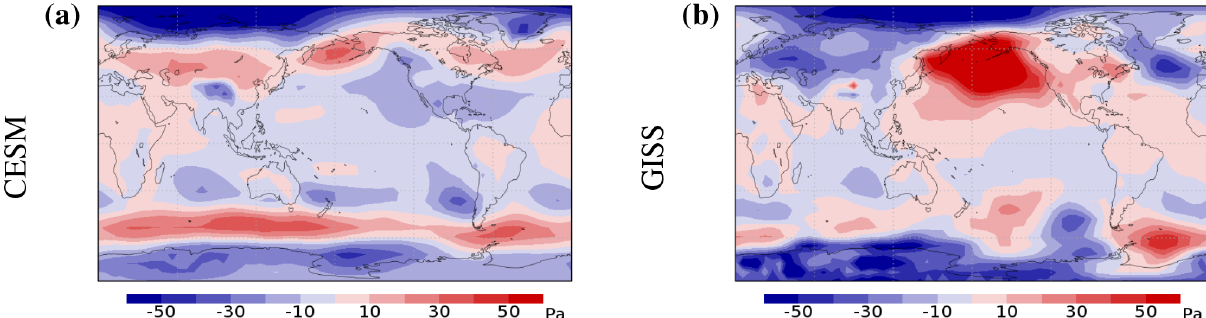
Figure 6. Maps of SLP anomalies for the 10 years after the 12 main volcanic eruptions of the LM. (a) Average of simulations from the CESM subensemble. (b) Average of simulations from the GISS subensemble.